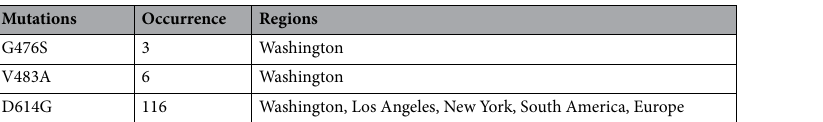
Mutations Occurrence